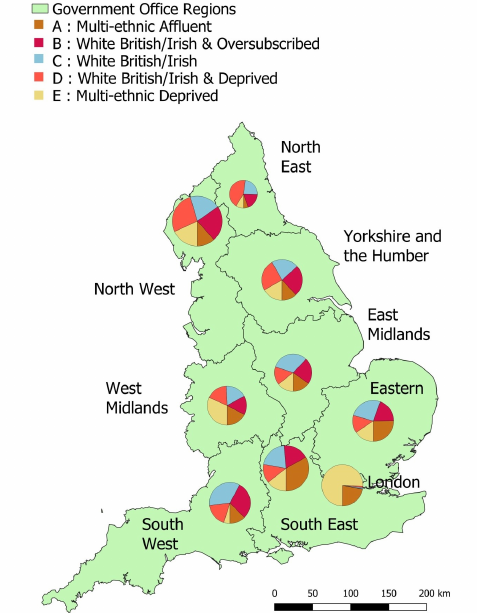
Figure 2: Geographic distribution of groupings by English